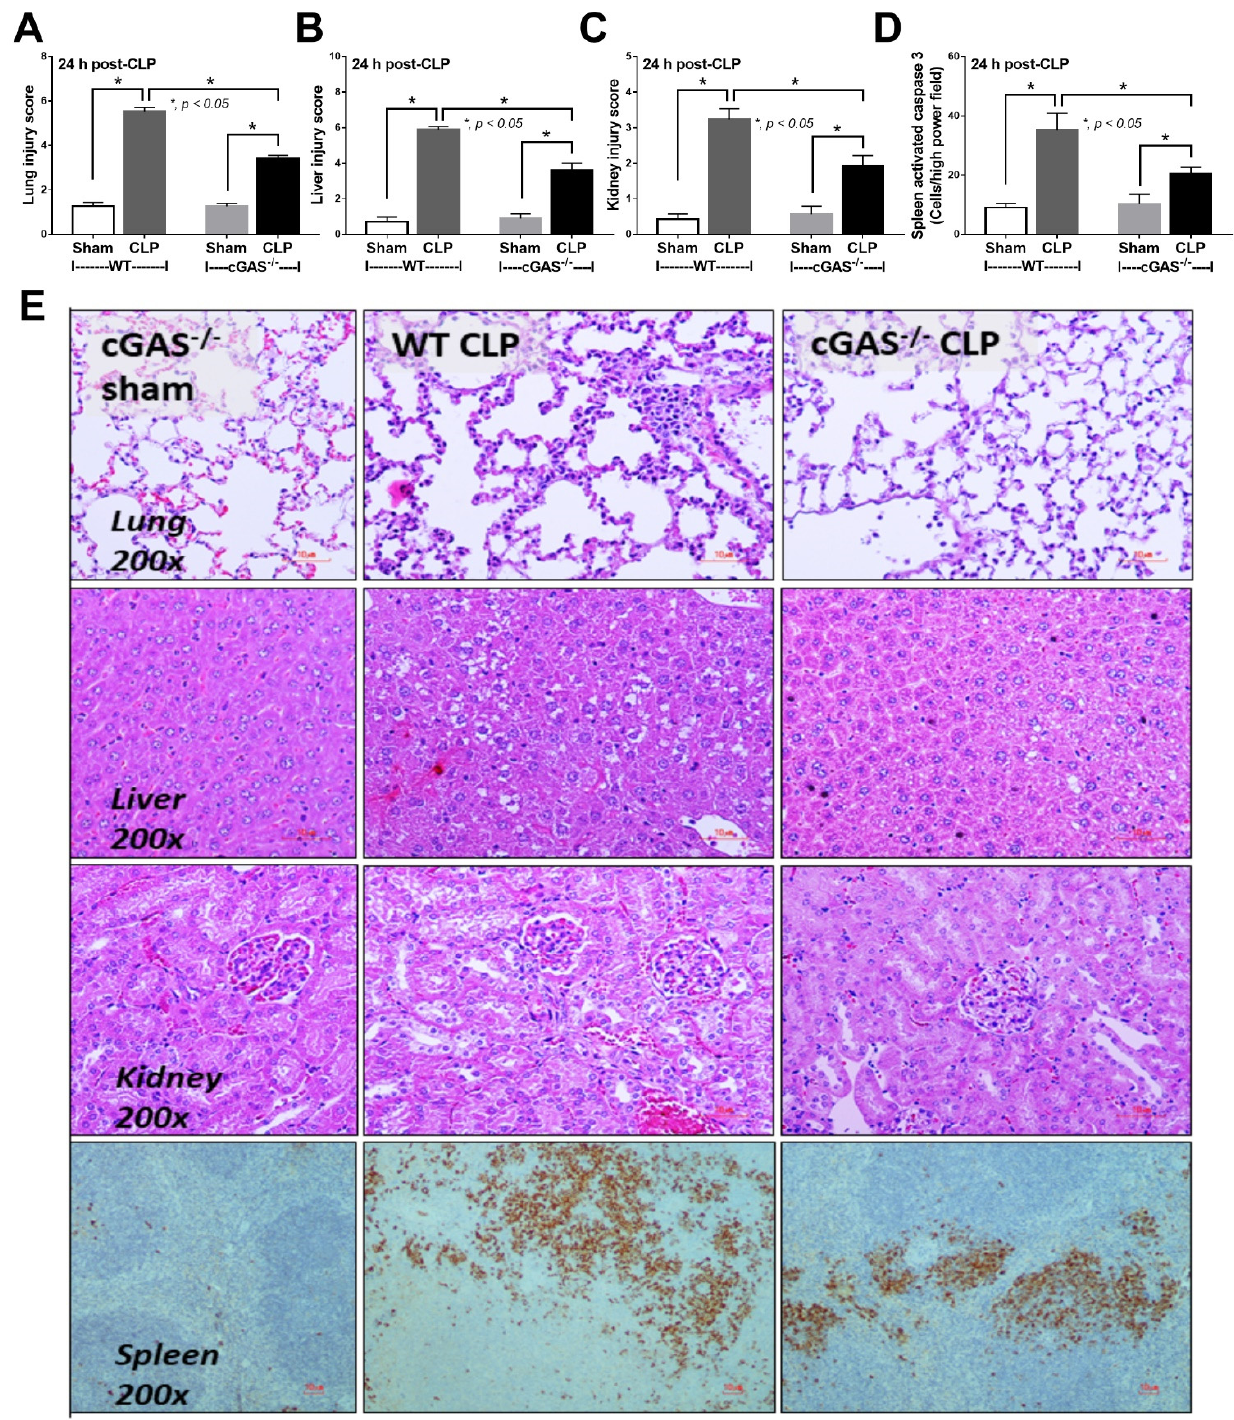
Figure 2. Characteristics of wildtype (WT) and cyclic GMP–AMP synthase deficient (cGAS -/- ) mice after sham or cecal ligation and puncture (CLP), as indicated by pathological score of lung liver and kidney ( A – C ), with activated caspase 3 apoptotic cells in the spleen ( D ) and representative histopathology on H&E staining (lung, liver and kidney) and activated caspase 3 immuno-histochemistry (spleen) ( E ) ( n = 6–8/group).